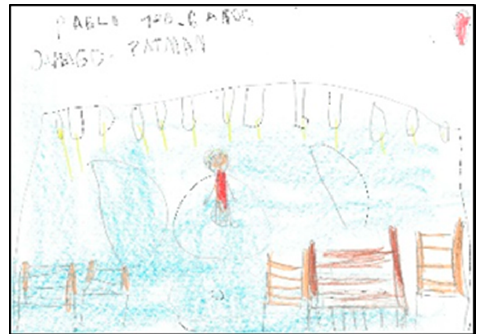
Figure 8. Represented space. Pablo. 1°B.